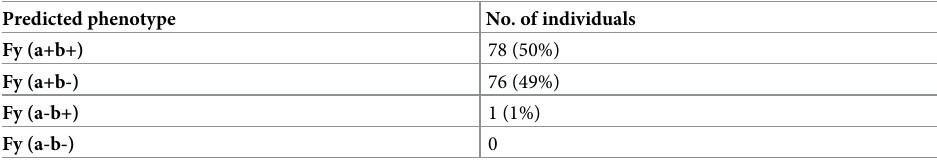
Table 2. Proportion of predicted phenotypes of blood donors and P . knowlesi infected